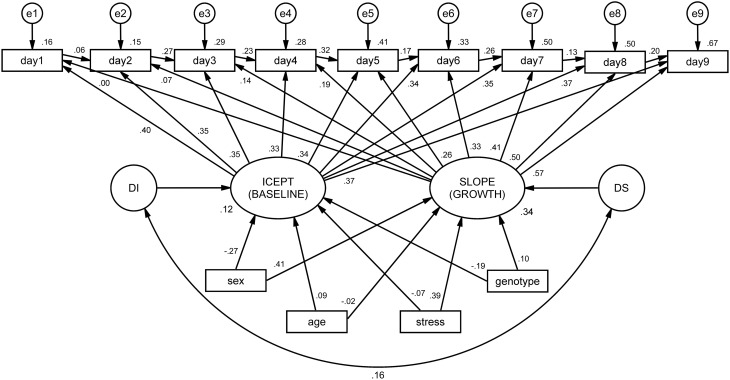
ALT model for mean latencies on the Morris water maze (MWM), conditioned by sex, age, stress and genotype. Squares and circles represent observed and unobserved (latent) variables, respectively. Observed variables “day1” to “day9” represent the individual latencies for each day of the MWM test. The arrows linking these variables form the auto-regressive subpart of the ALT approach (these can be interpreted as regression coefficients). Variables “e1” to “e9” represent measurement error terms for each acquisition day. These measurement errors correct the measured variances for random error. “ICEPT” (intercept) represents animals' baseline performance (estimated by the linear growth). In a Cartesian coordinate system, this variable represents the value of y when x is zero. In ALT models, it provides information about the sample mean and variance of the collection of intercepts that characterize each animal's latencies. The “SLOPE” represents the linear evolution of the latencies for each animal throughout time. “DI” and “DS” (D stands for disturbances) represent the variance of the intercept and slope, respectively. At the bottom, intrinsic and extrinsic factors are represented to observe their influence on the intercept and slope.